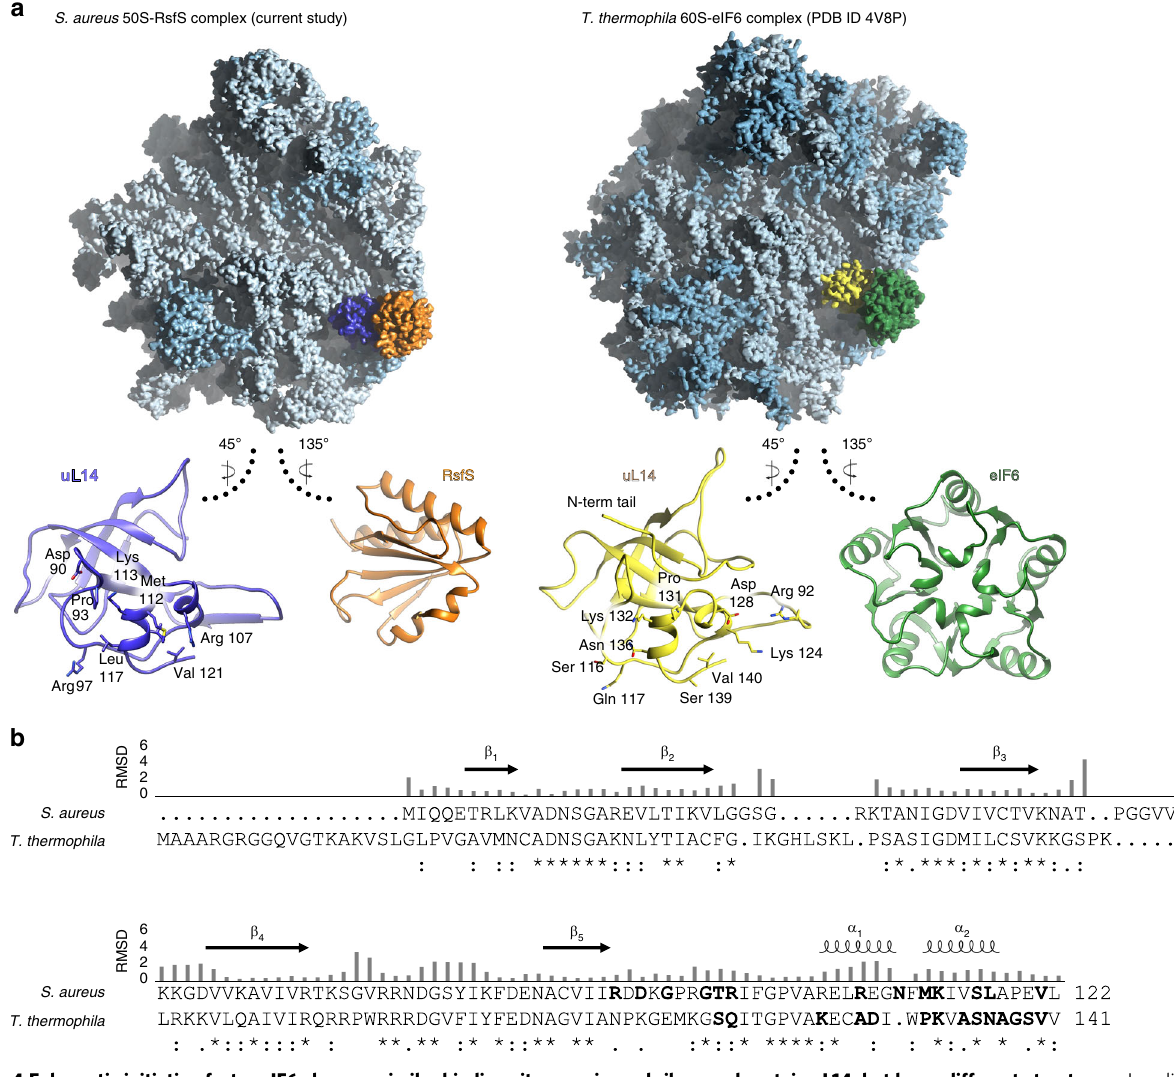
Fig. 4 Eukaryotic initiation factor eIF6 shares a similar binding site on universal ribosomal protein uL14, but has a different structure. a Localization of RsfS and eIF6 proteins on S. aureus 50S and Tetrahymena thermophila 60S, respectively. For a visual representation, the maps were simulated from the atomic coordinates of the models. Ribosomal RNAs are colored in light blue, ribosomal proteins in blue, S. aureus uL14 in dark blue, RsfS in orange, T. thermophila uL14 in yellow, and eIF6 in green. Individual proteins are shown in ribbon to represent their interaction interface, which displays the structural similarity of uL14 and the dissimilarity of the RsfS and eIF6 proteins in the two organisms. Residues of uL14 involved in the interaction with RsfS/eIF6 are shown as sticks, and labeled accordingly. b Pairwise sequence alignment of uL14 from S. aureus and T. thermophila demonstrates their high sequence similarity. Secondary structure elements are shown above the alignment. Residues interacting with RsfS (or eIF6) are highlighted in bold. The RMSD (given in Å) of 3D structure alignment is shown as bars above the sequence. An asterisk indicates a single, fully conserved residue (identity), colon indicates conservation between amino acids with substantial chemical similarity, while dot indicates conservation between amino acids with poor chemical